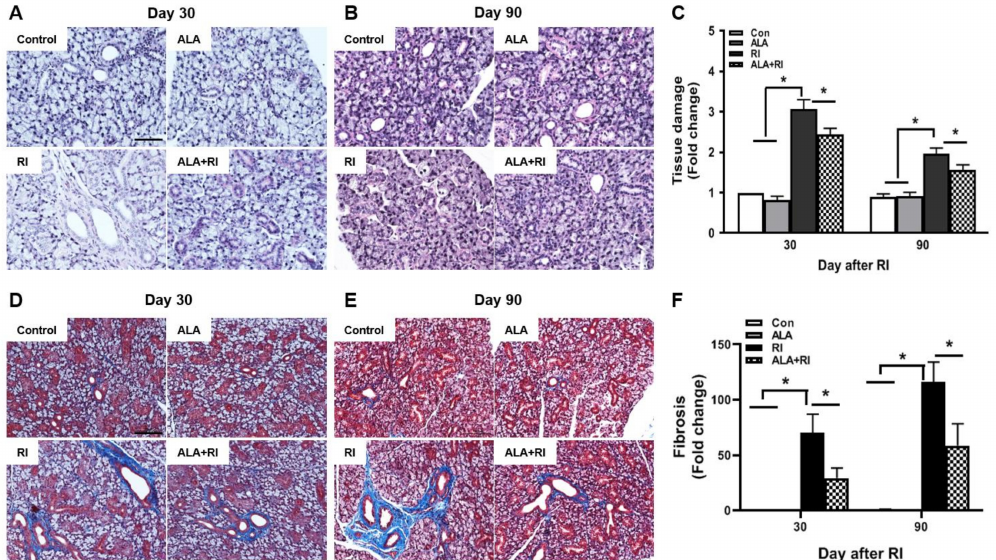
Figure 2. Pathological findings following radioiodine (RI) therapy. ( A – C ) Representative morphological images of acinar and ductal cells in the salivary glands (SGs). Control and alpha lipoic acid (ALA) glands showed preserved structure of the glands. RI-treated glands showed severe tissue injury. ( D – F ) Representative Masson’s trichrome-stained sections of the SGs. Interstitial and vascular fibrosis in the SGs was minimal in the control and ALA groups, but was significantly greater in the RI only group than in the RI + ALA group. ( A , D ) 30 days post-RI therapy; ( B , E ) 90 days post-RI therapy. Data are means ± SD. * P < 0.05 compared to the indicated groups. Scale bars: 100 µ